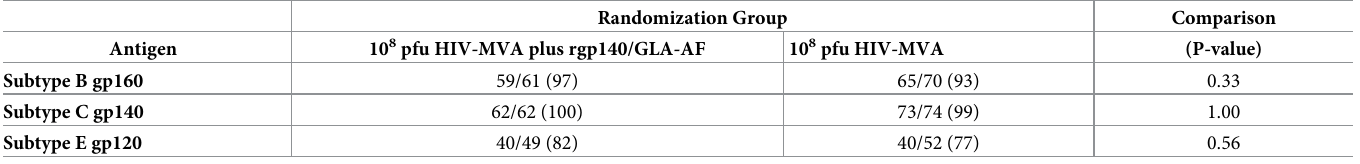
Table 3. Frequency of antibody responses as determined by ELISA four weeks after the final vaccination.